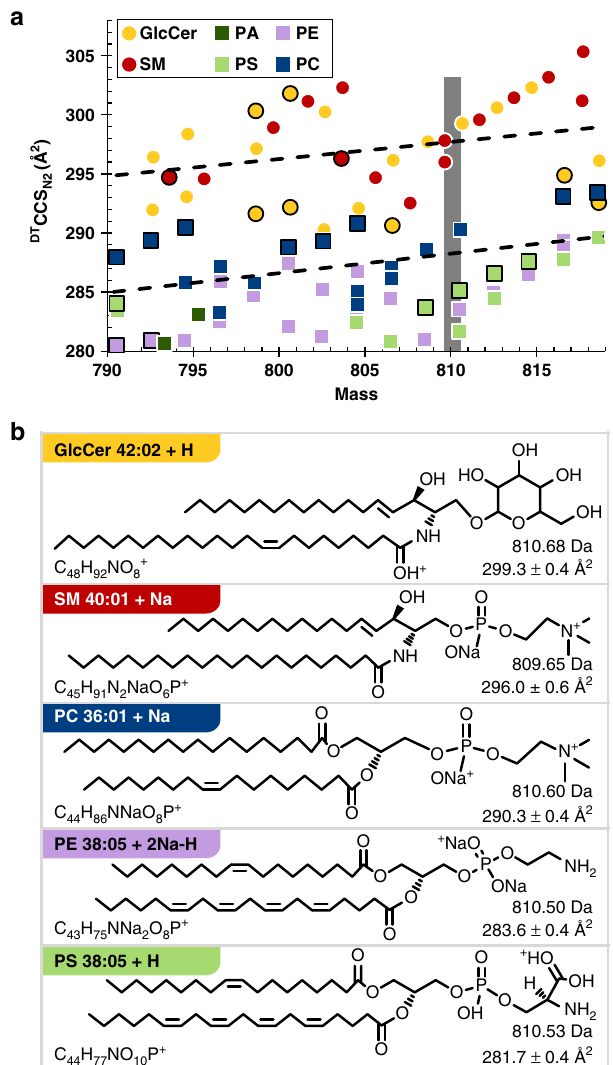
Fig. 3 Conformational space occupancy of lipids within a narrow range of mass. a Expanded region from Fig. 2 highlighting occupancy of each lipid class by mass and DT CCS N2 . Note the largest DT CCS N2 difference for peaks of similar mass is between glycerophospholipids and sphingolipids. Markers for cations are indicated by a white border while those for anions are indicated by a black border. Error bars represent standard errors and are within the marker itself for each point. b Primary structures of the fi ve positively charged nominal mass isomeric lipid ions (809.6 – 810.7 Da, SM structure is for the feature of lesser cross section) highlighted in panel A. DT CCS N2 values are all statistically different and largest for sphingolipids. Note structural information is inferred from rules described by Voet, et al. with (i) lipids assembled as concatenations of C 2 units making even-numbered chains prevalent, (ii) the fi rst unsaturation site preferably located between C9 and C10, (iii) subsequent unsaturation sites occurring every third bond, and (iv) double bonds existing primarily in the cis- con fi guration 44 . Poly-unsaturated fatty acyl side chains are constructed from commonly encountered fatty acid structures with preference for ω -3 and ω -6 chains. Adducts are shown at likely basic sites. Additionally, sphingolipids contain a sphingosine backbone. Speci fi c lipid identi fi cations, numerical measurement data, and number of measurements per data point ( n = 8 or 16 repeat measurements for positive ionization mode data, n = 20, 21, or 28 repeat measurements for negative ionization mode data) are provided in Supplementary Data 1